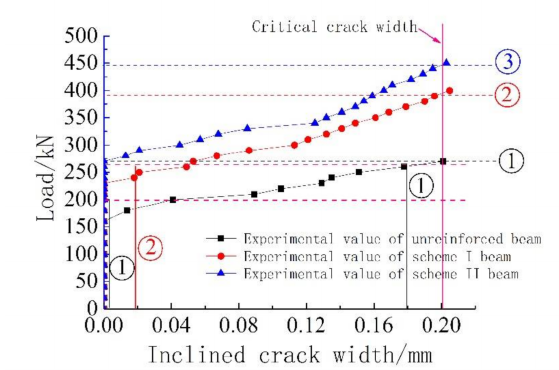
Figure 17. The experimental value of inclined crack width under three working conditions. Note: 1 (cid:13)